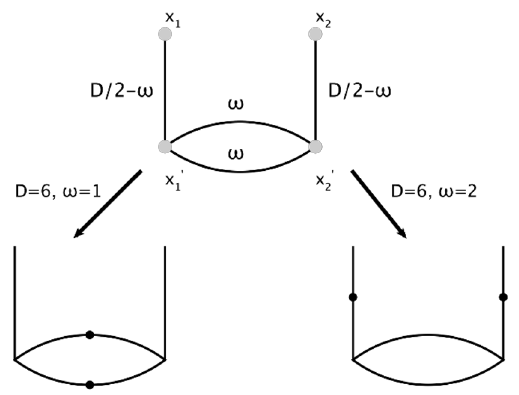
Figure 5 . Graphical representation of the Graph building operator H 2 and the corresponding Feynman diagram element whose H will generate in momentum space in the D = 6 , ω = 1 and 2 ω = 2